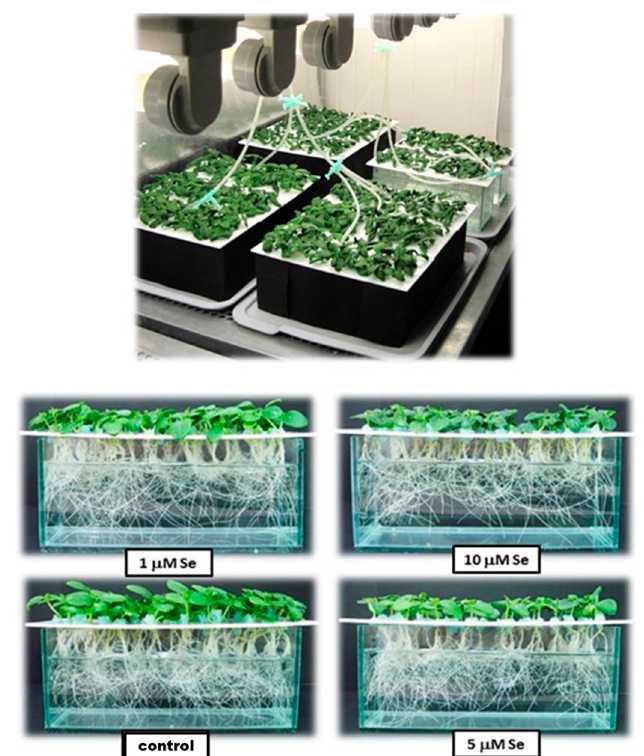
Figure 11. Seedlings of cucumber pre-treated with Se in the growth chamber before introducing the WD.